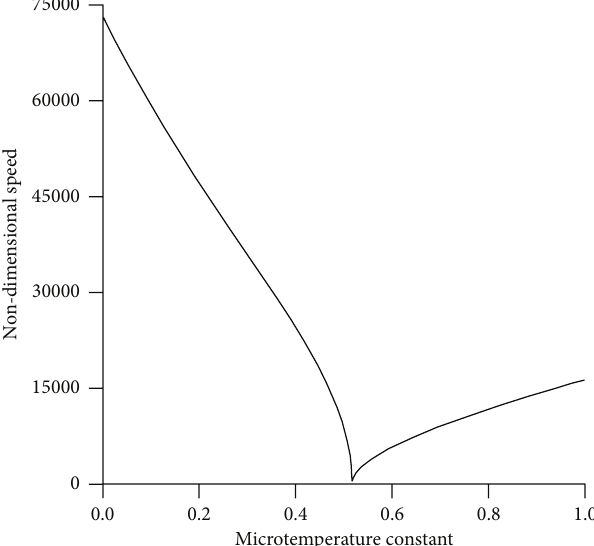
1/2 of Figure 5: Variation of the nondimensional speed (𝜌𝑐 2 /𝜇) Rayleigh wave versus microtemperature constant 𝐾 6